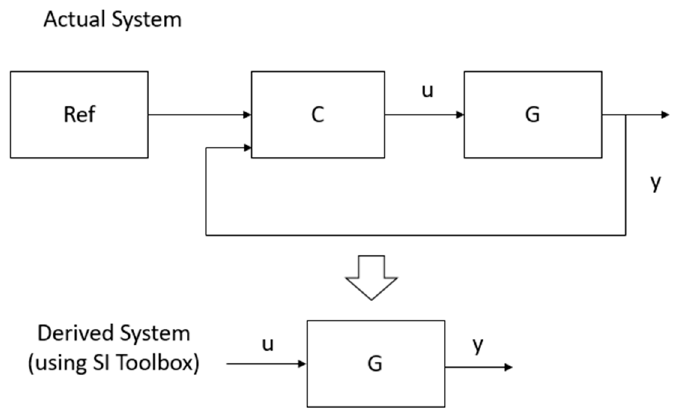
Figure 5. A block diagram of actual and derived (using SI toolbox) elbow revolute joint system.